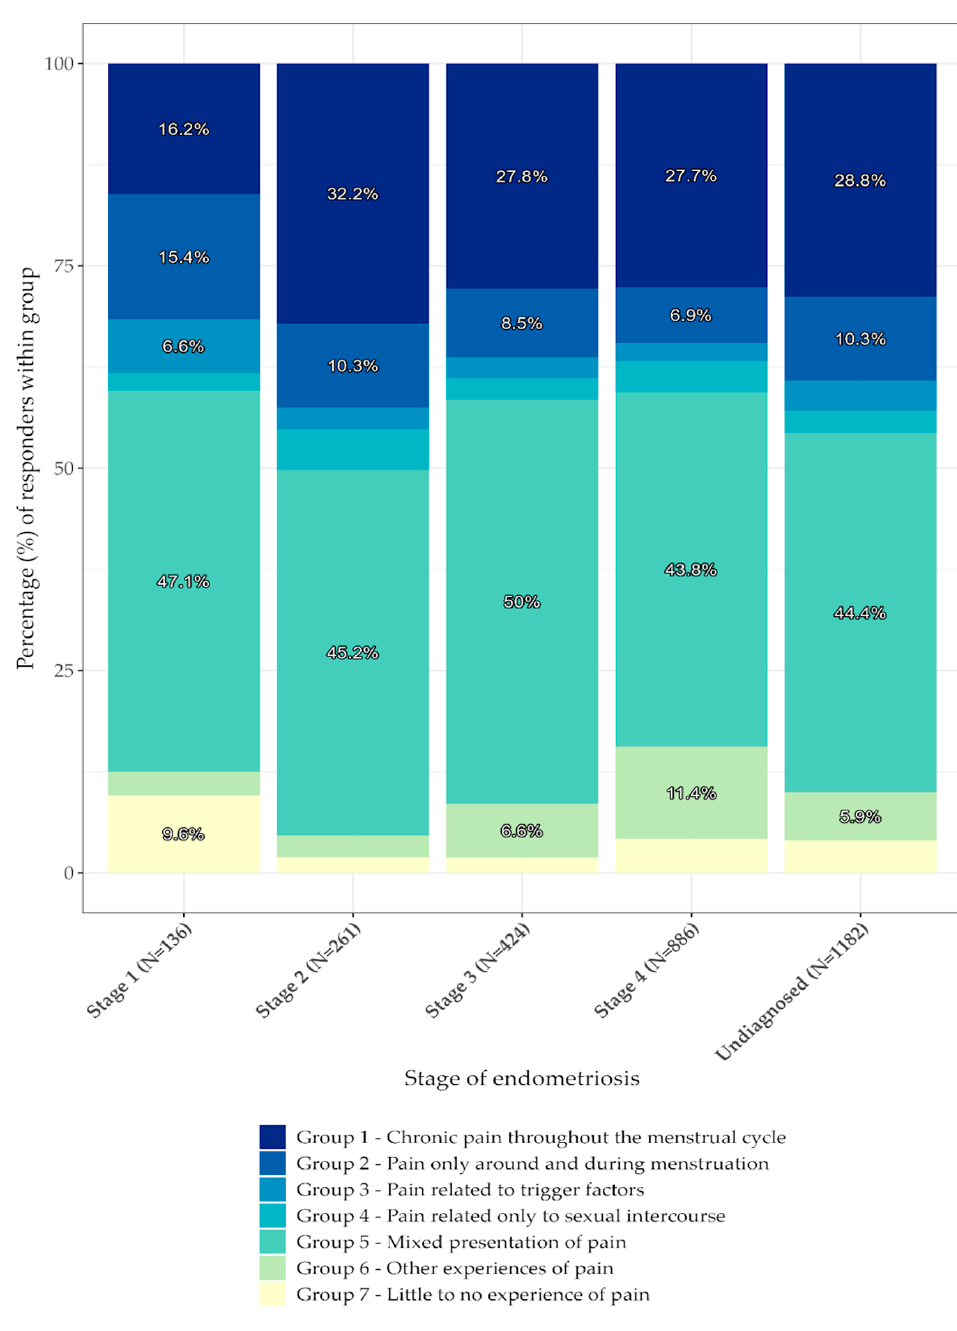
Figure 2. Reported experiences of pain in relation to stage. The figure shows the percentage of participants within a defined group and their reported pain related to the stages of disease. The percentages of respondents are shaded. The darkest shade represents group 1, and gets brighter until group 7, which is represented by the brightest shade.